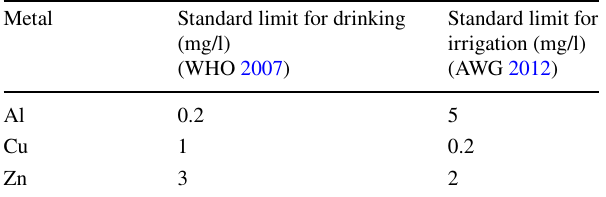
Table 2 Recommended standard limits for drinking and irrigation water